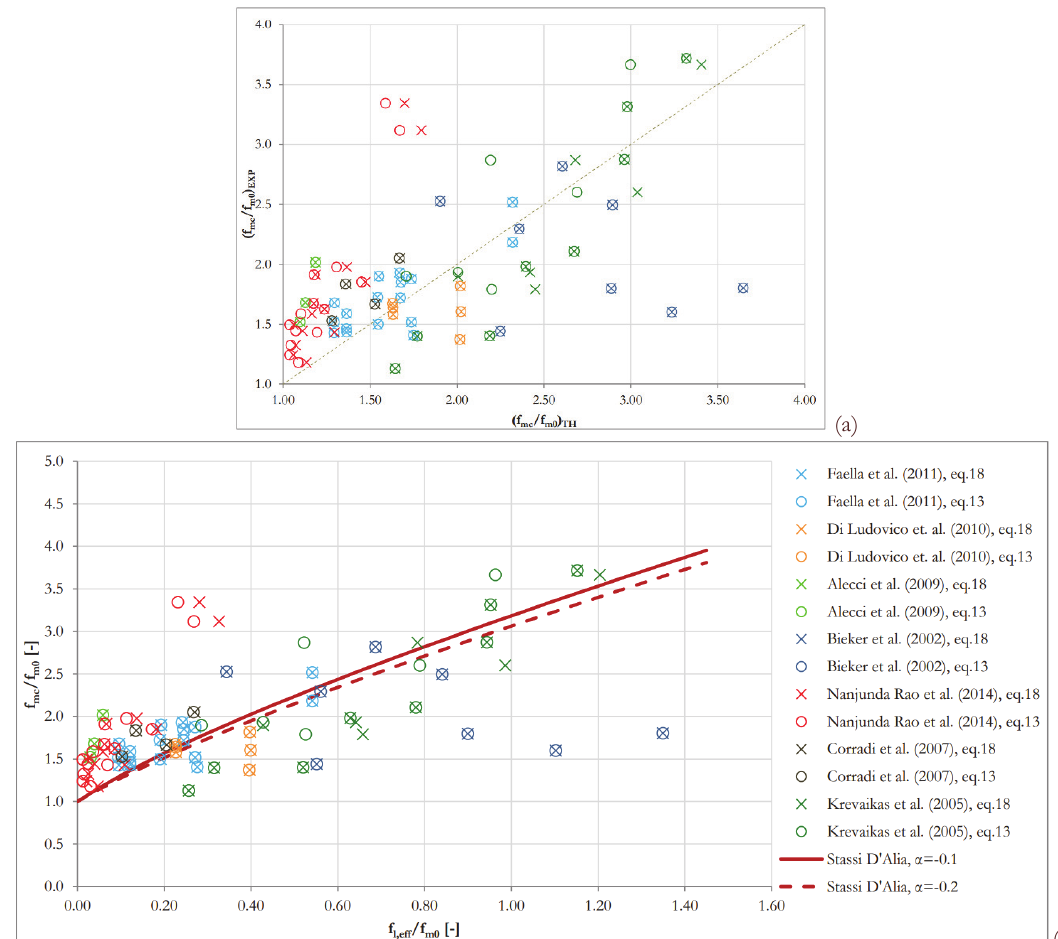
Figure 5: Comparison between experimental results and Stassi-D’Alia model: a) experimental and theoretical results comparison, b) confinement curve comparison for α =-0.1 (red solid line) and α =-0.2 (red dashed